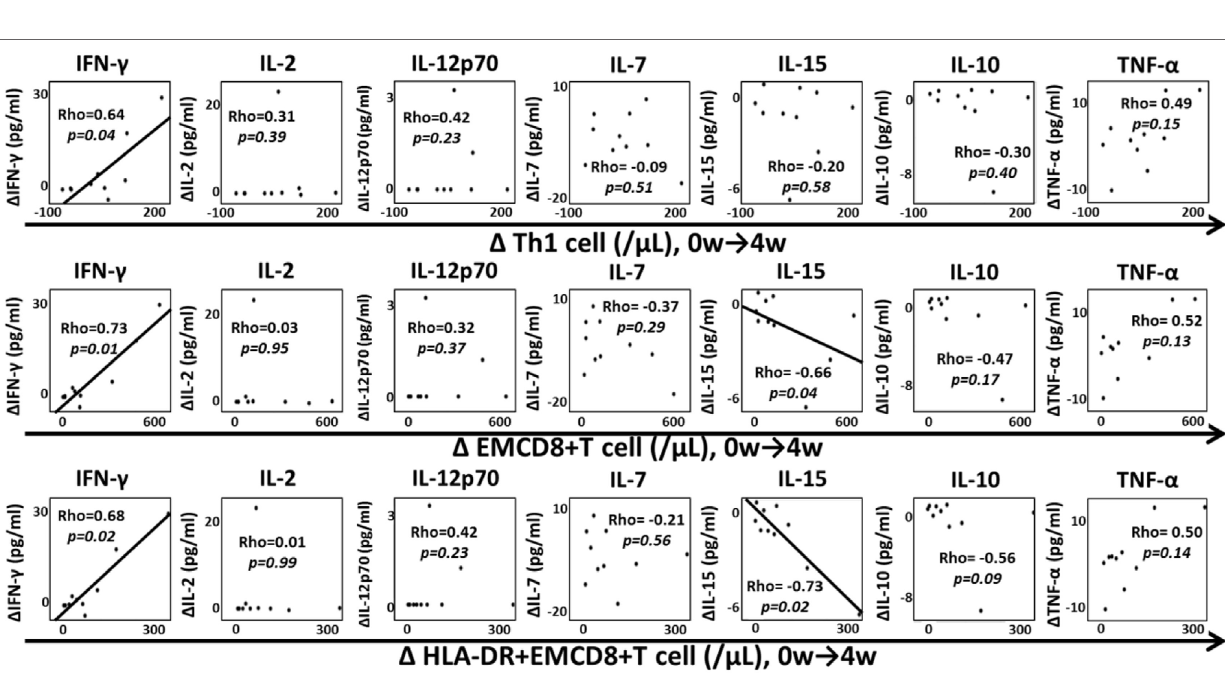
Figure 8 | Correlation between increased lymphocyte subsets and cytokine change. Correlation between increase in Th1 cells, EMCD8 + T cells, HLA- DR + EMCD8 + T cells, and changes in interferon (IFN)- γ , IL-2, IL-12p70, IL-7, IL-15, IL-10, and TNF- α from weeks 0 to 4. Correlations were analyzed by Spearman’s correlation coefficient. Th1, T helper 1; EM, effector